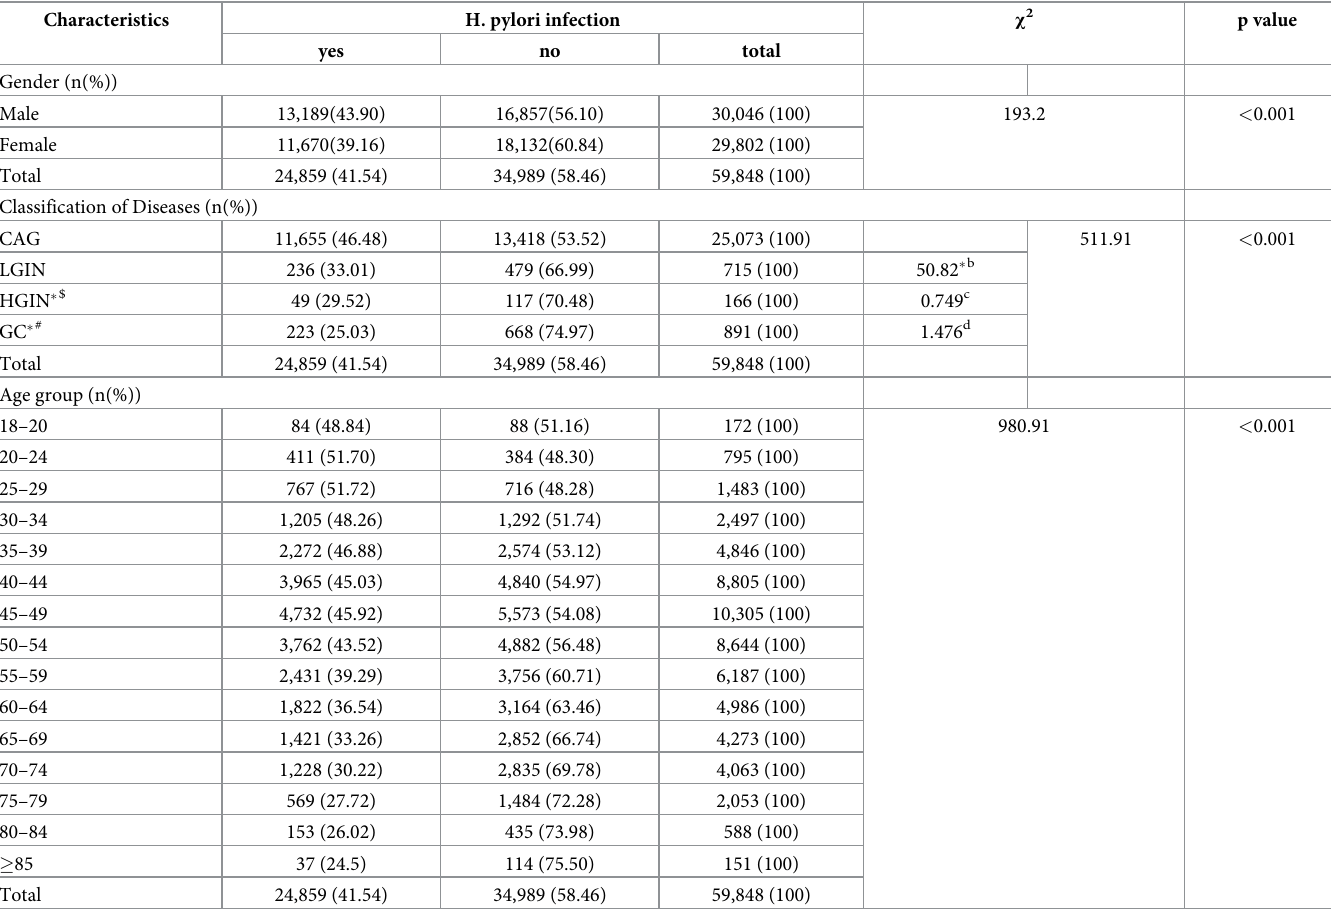
Table 2. Comparisons of basic characteristics in patients with and without infection H. pylori.